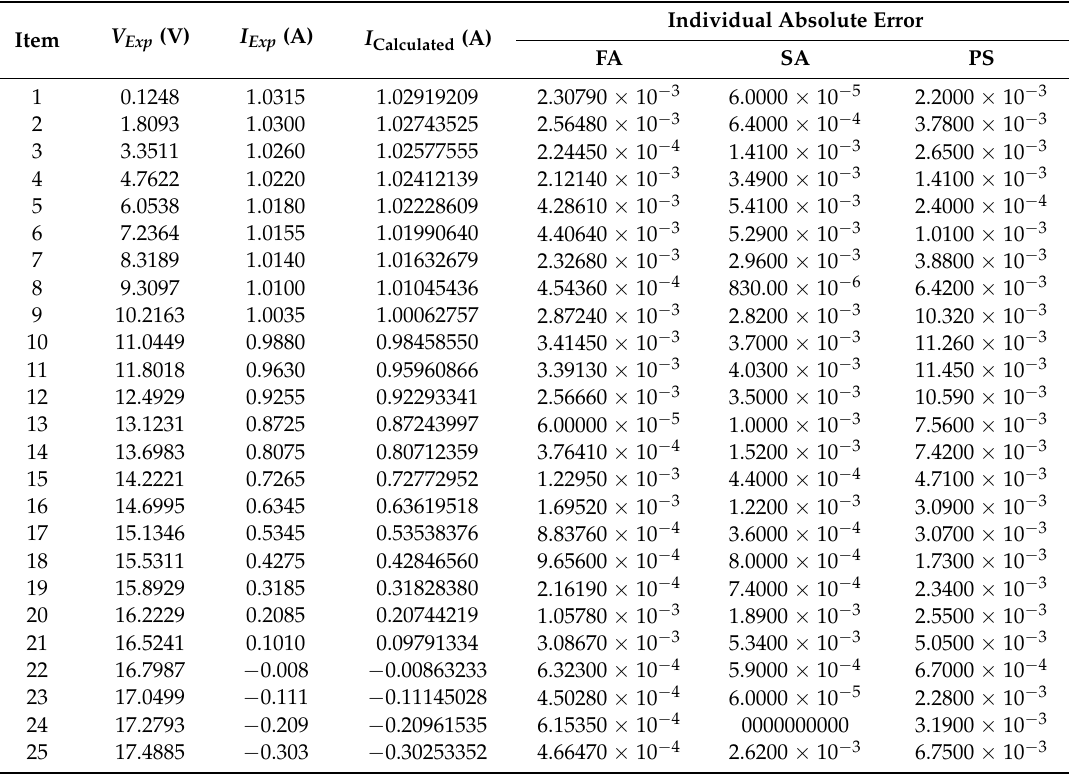
Table 13. Measured and calculated current of photovoltaic module Photowatt-PWP 201 at 25 different working conditions compared with SA and PS.